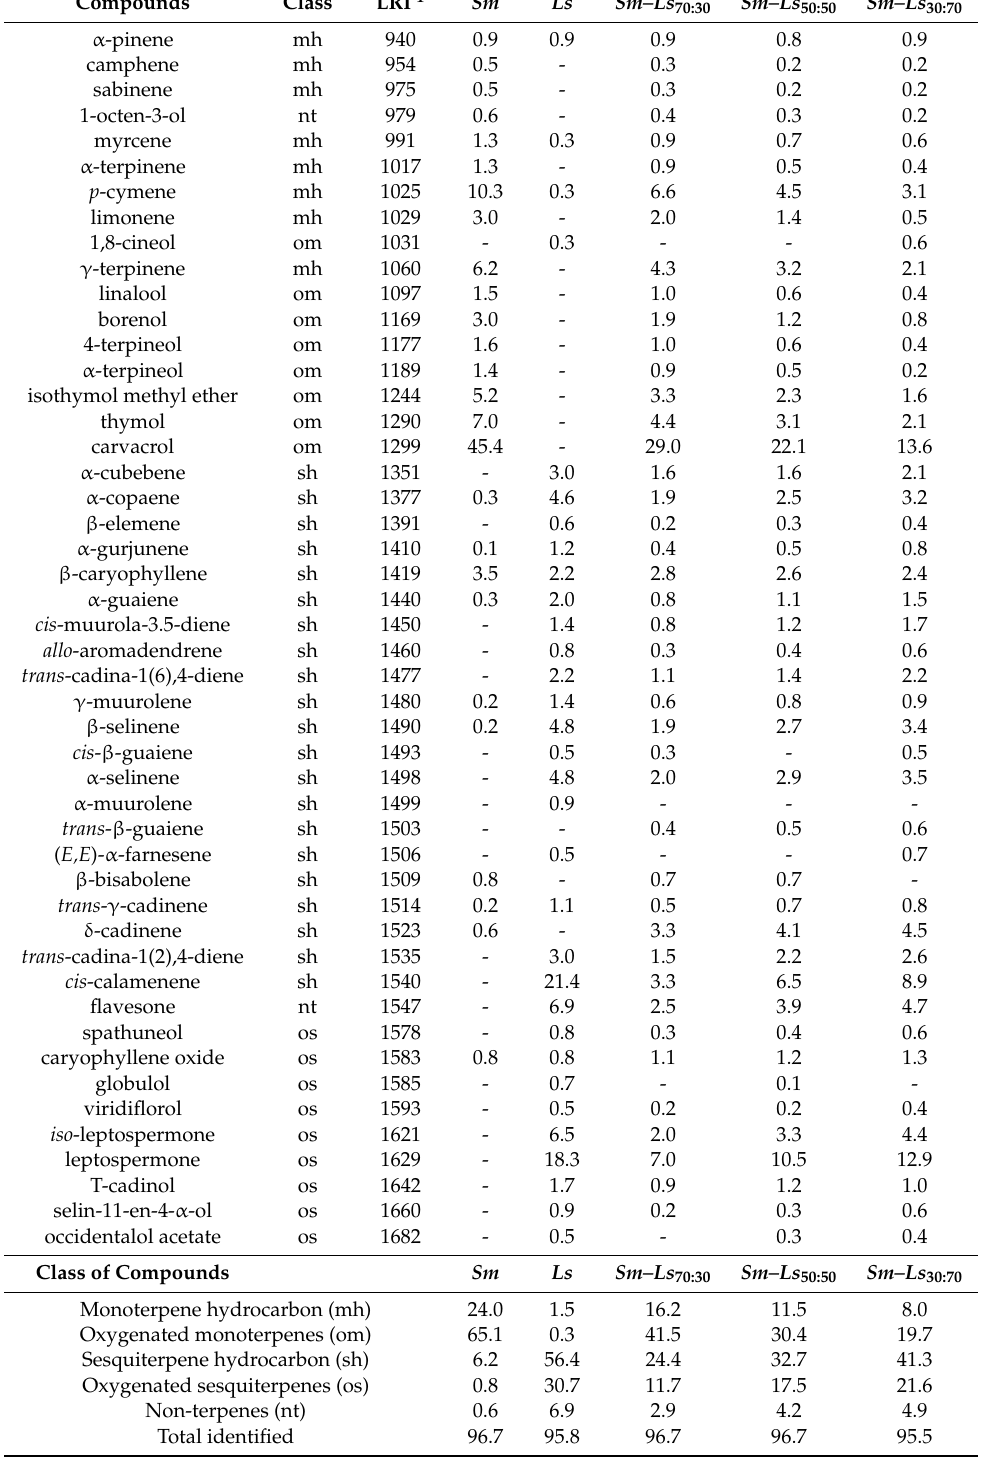
Table 2. Essential oil (EO) composition of winter savory ( Sm ), manuka ( Ls ) and the three Sm–Ls